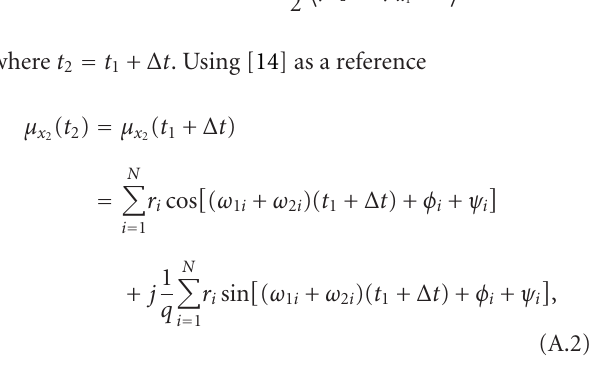
Figure 8: Time Autocorrelation function of Real part of Envelope for q = 0 . 5, k =